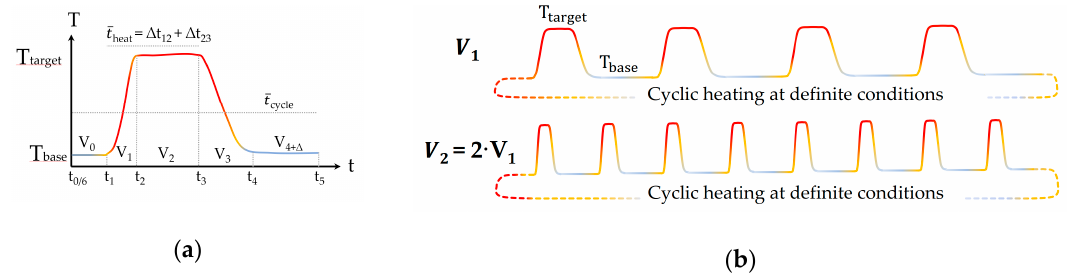
Figure 15. ( a ) Schematic view of one single heating cycle from T base to T target and back to T base and ( b ) illustration of periodic heating cycle with two different flow rates but identical treatment time, t eff , of the heating system described in Figure 14.